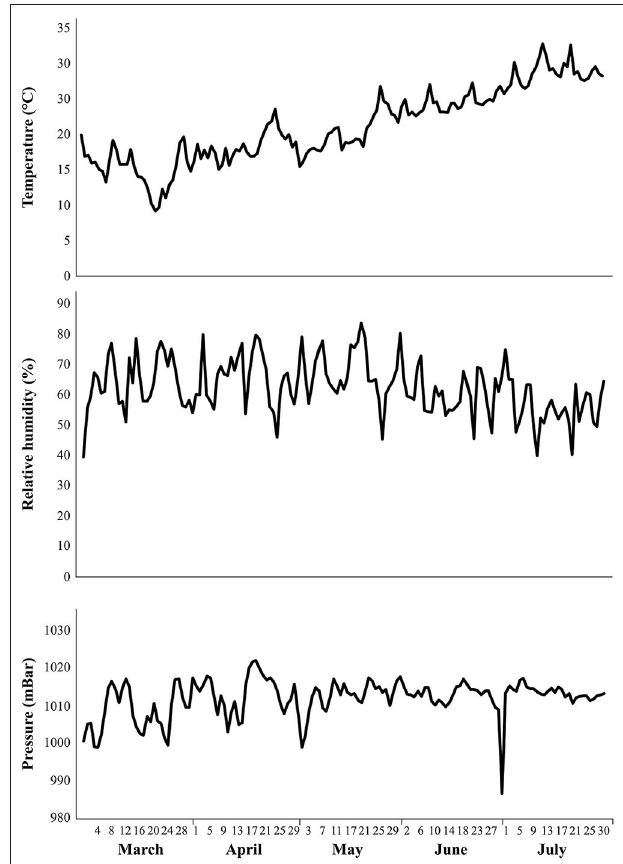
FIGURE 1 | Temperature ( ◦ C), relative humidity (%), and atmospheric pressure (mBar) data were recorded by the weather station of the National Agricultural of Tunisia (Lat 40 ◦ 20 ′ N, Lon 18 ◦ 07 ′ ) of the University of Carthage. The reported values refer to 2018 and cover the entire tomato plant growing season